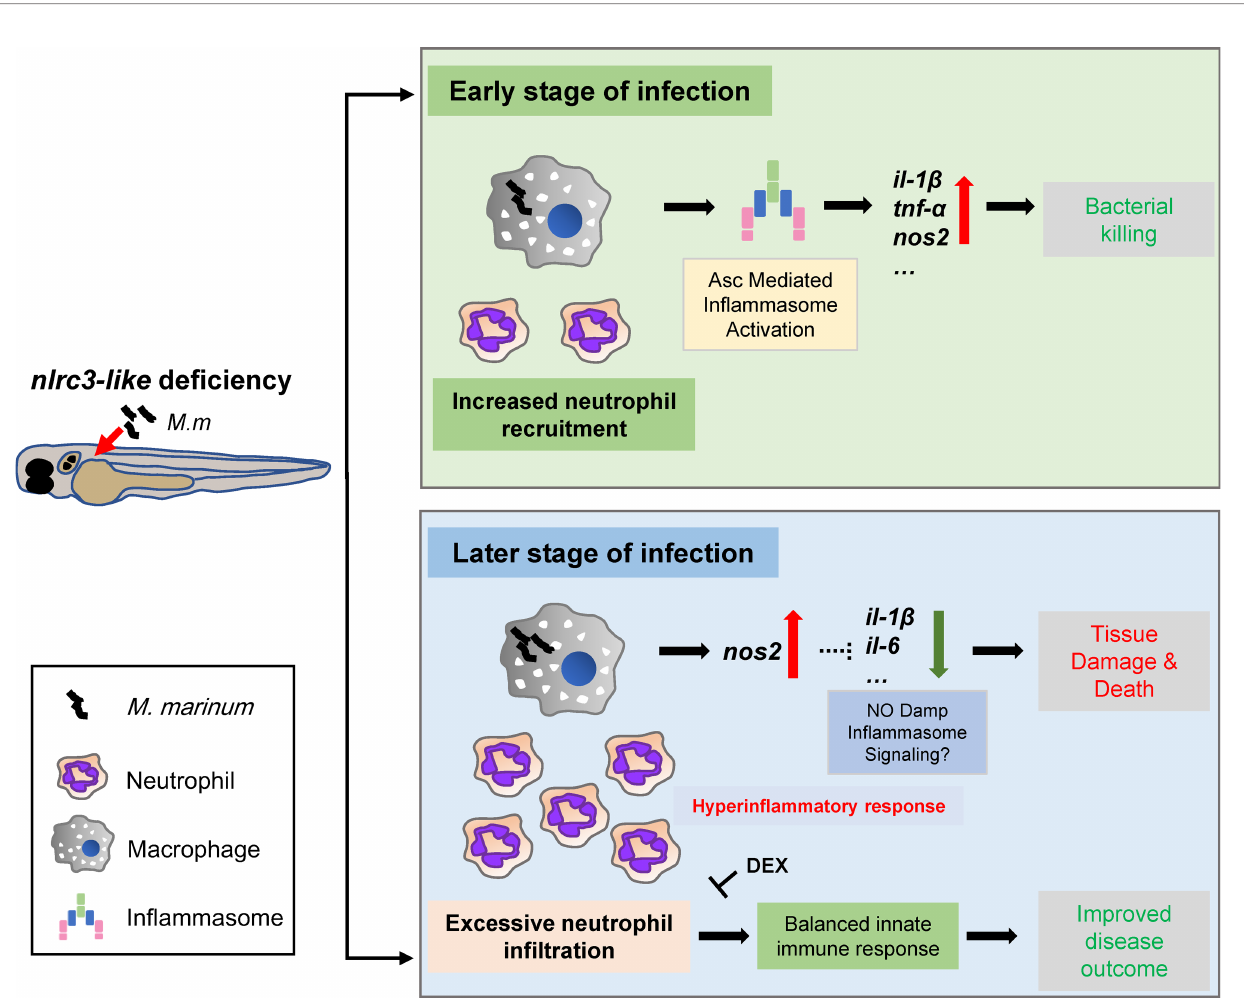
FIGURE 7 | Model for the impact of negative regulator NLR nlrc3-like on innate immune responses during mycobacterial infection. During the early stage of infection, the defect of nlrc3-like can boost the expression of mycobacterial elicited pro-in fl ammatory genes via Asc mediated in fl ammasome activation in infected macrophages, which results in a bacterial killing effect accompanied by an increased neutrophil recruitment. However, during the late stage of infection the host shifts into a hyperin fl ammatory status with uncontrolled excessive neutrophil in fi ltration and increased tissue damage and death. The administration of DEX can block the excessive in fl ammatory response and improve disease